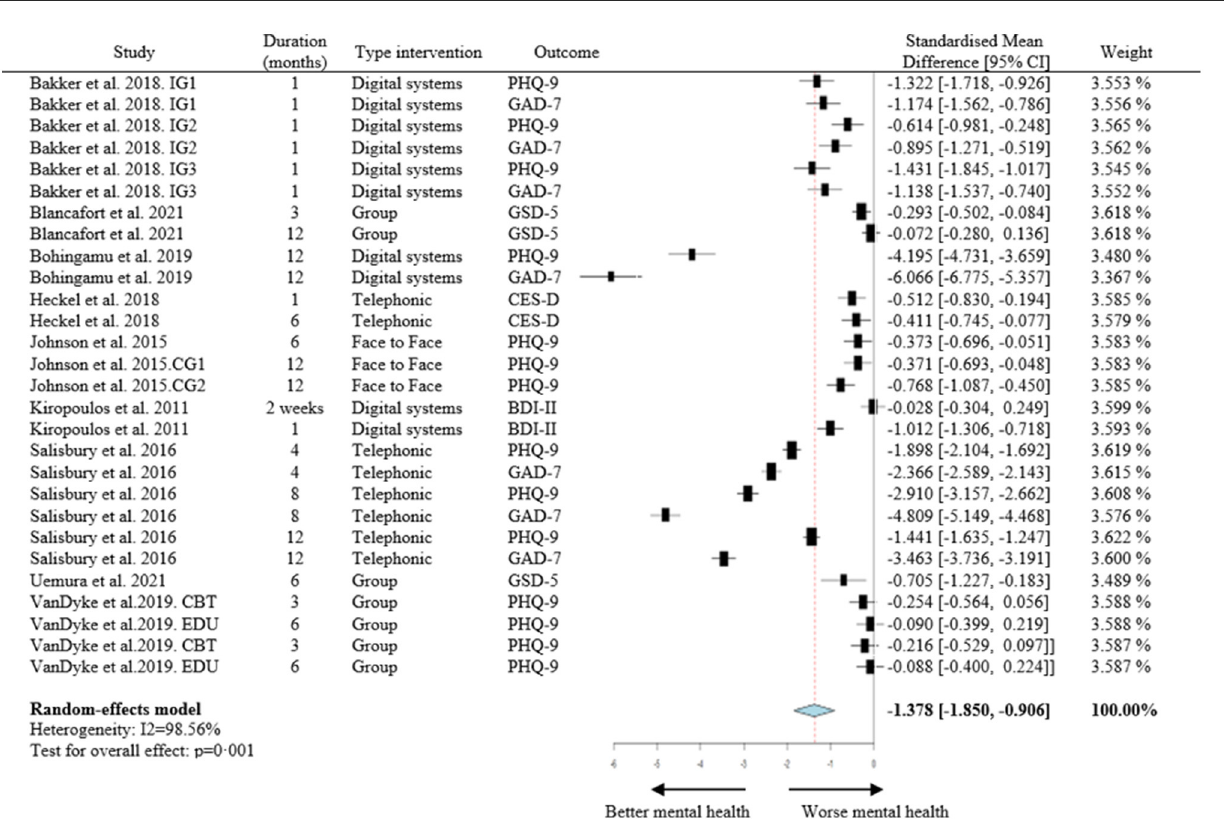
FIGURE3 Forest plot for meta-analysis of studies reporting the effect on mood disorders. 95% CI: 95% confidence intervals; IG1, intervention group 1 (moodkit); IG2, intervention group 2 (moodprism); CG1, control group 1 (active control); CG2, control group 2 (usual care); CBT, cognitive behavioral treatment; EDU, psychoeducation groups; PHQ, Patient Health Questionnaire; GAD-7, general anxiety disorder; GDS, Geriatric Depression Scale; CES-D, Center for Epidemiological Studies Depression Scale; BDI-II, Beck Depression Inventory.